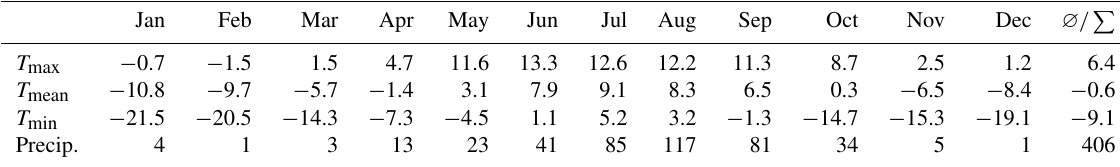
Table 1. Average daily air temperature (maximum, mean and minimum in ◦ C) and average daily precipitation (sum in mm) from NAMORS from 2006 to 2017. Calculations were performed using the tidyverse package family in R on RStudio environment (Wickham, 2017; RStudio Team, 2018; R Core Team, 2019). Data provided by ITP Beijing; for details about sensor equipment, see Ma et al. (2009). Jan